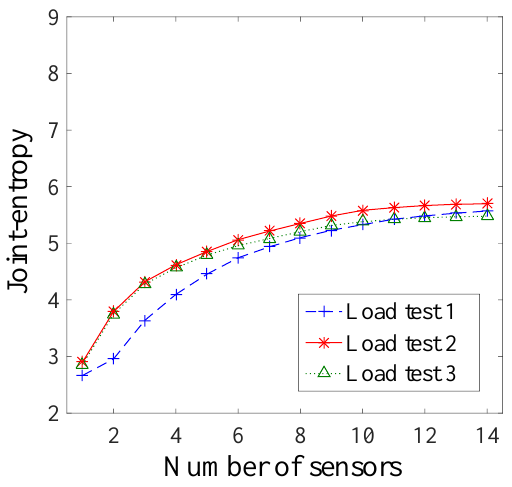
Figure 10. Joint entropy of the sensor configuration as a function of the number of sensors for each load test.